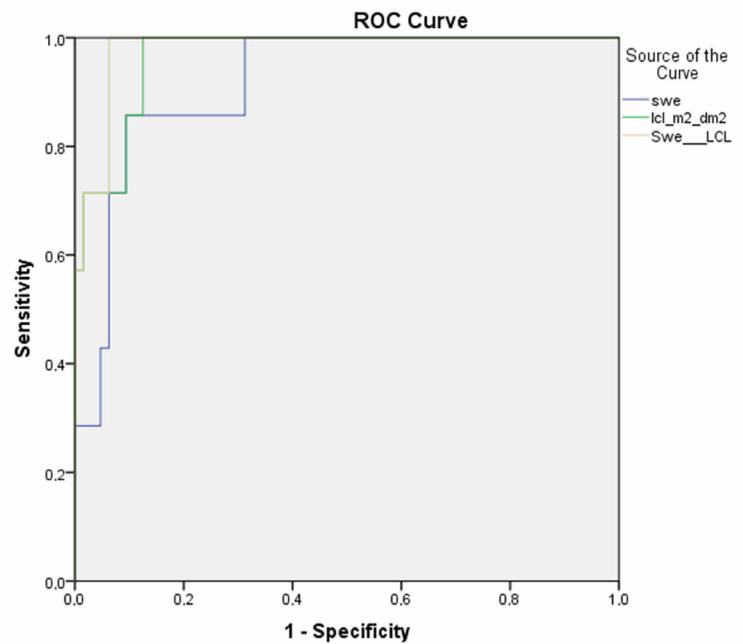
Figure 6. Combination of adding 2D-SWE and dynamic liver scintigraphy with 99mTc-mebrofenin together in liver cirrhosis group—the AUROC increased from 0.91 to 0.98. swe—2D-SWE curve before combination; lcl_m 2 _dm 2 —liver clearance measured in right liver lobe and corrected using BSA and LA curve before combination; SWE__LCL—combined